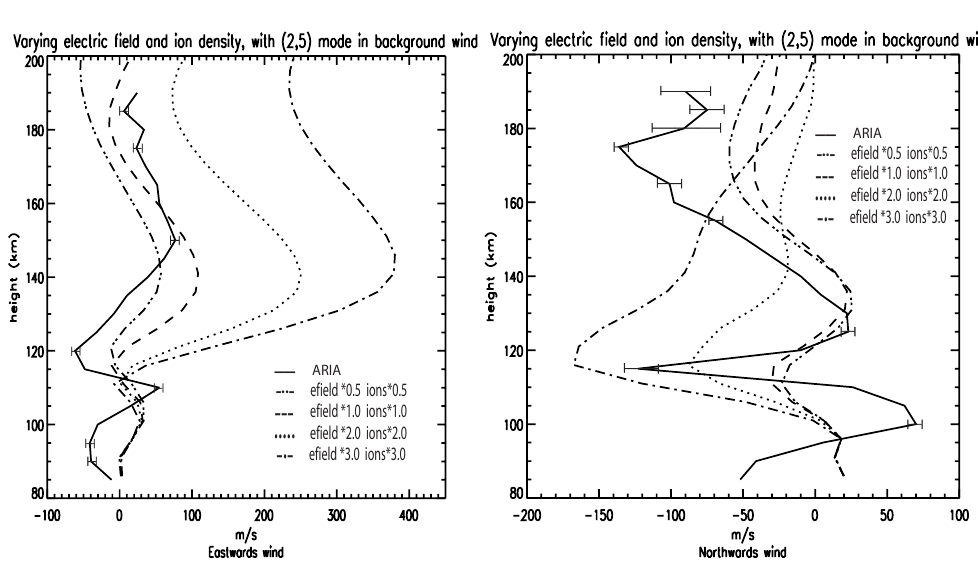
Fig. 6. (a) , (b) Response of the neutral winds to varying electric field and ion density enhancement, with (2,5) tidal mode in the background winds. The ARIA I observations are included for